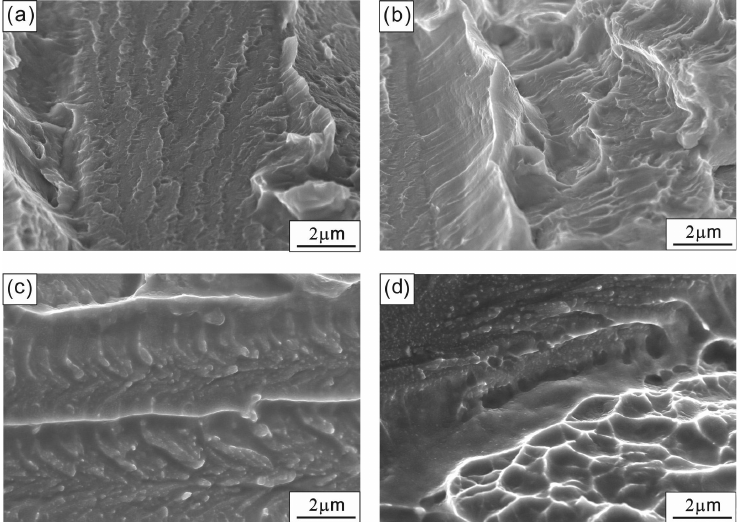
Figure 7. The higher magnification SEM fractographs of Ti15Sn x Cu alloys: (a) AS Ti15Sn, (b) HT Ti15Sn, (c) AS Ti15Sn2Cu and (d) HT